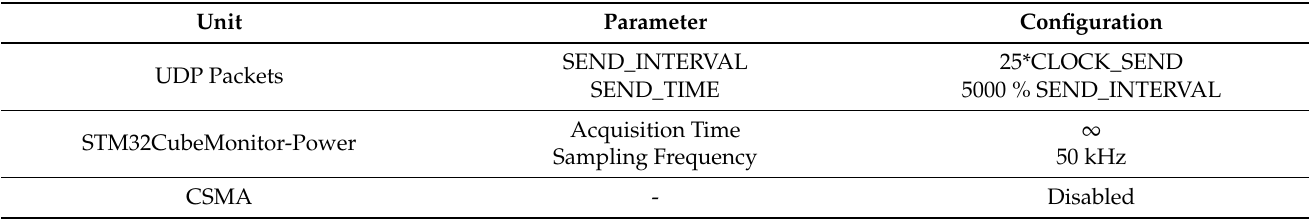
Table 2. Configured